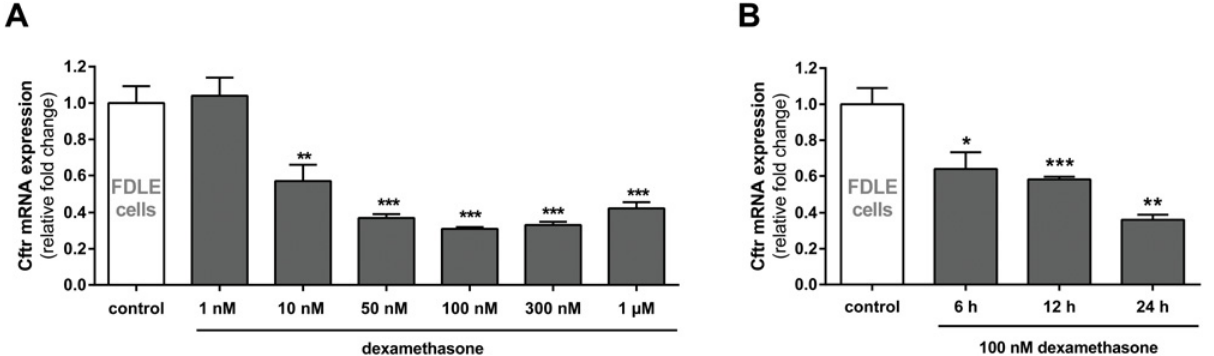
Fig 1. Dexamethasone reduces Cftr mRNA expression in FDLE cells. Graphs represent the mean + SEM for normalized Cftr mRNA expression acquired by RT-qPCR. A: Dose-response curve of dexamethasone effect (1 nM – 1 μ M for 24 h, n = 4, ** p < 0.01; *** p < 0.001, ANOVA with Dunnett's post hoc test compared to control monolayers without dexamethasone addition). B: Time course of Cftr mRNA expression in response to 100 nM dexamethasone for 6, 12 and 24 h (n = 4, * p < 0.05; ** p < 0.01; *** p < 0.001,